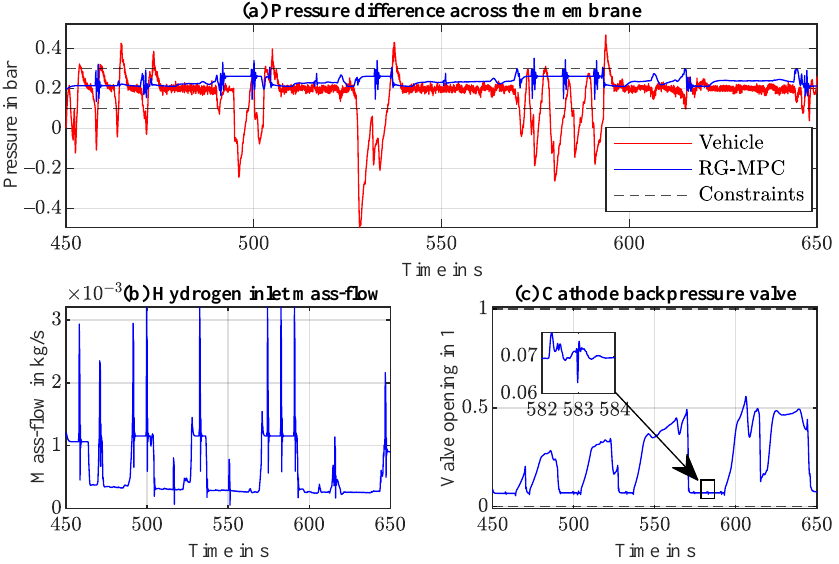
Figure 10. ( a ) Pressure difference across the membrane, ( b ) hydrogen inlet mass-flow, ( c ) cathode backpressure